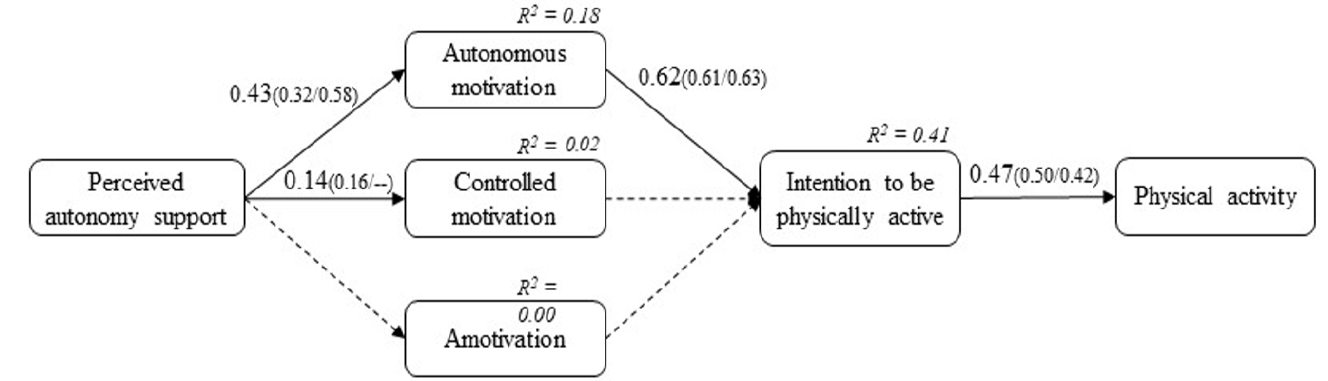
Figure 1. SEM of the hypothesized model for the full sample and for boys (first coefficient in brackets) and girls (second coefficient in brackets). Note: The coefficients shown are normalized and statistically significant at the 0.05 level. For reasons of parsimony, relationships that were not statistically significant are not shown. The relationship between autonomous motivation and controlled motivation (r = 0.24, p < 0.001; r = 0.22, p < 0.001 for boys, and r = 0.24, p < 0.001 for girls), autonomous motivation and amotivation ( r = 0.01, p = 0.947; r = 0.01, p = 0.934, and r = 0.04, p = 0.834 for girls), and the relationship between controlled motivation and amotivation ( r = 0.77, p < 0.001; r = 0.77, p < 0.001 for boys, and r = 0.78, p < 0.001 for girls). Non-significant paths were indicated with dashed